Question: Which kind of chart has been used to present this data?
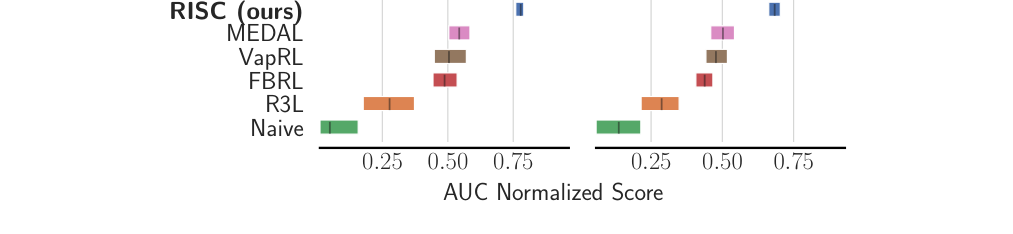
Answer: line